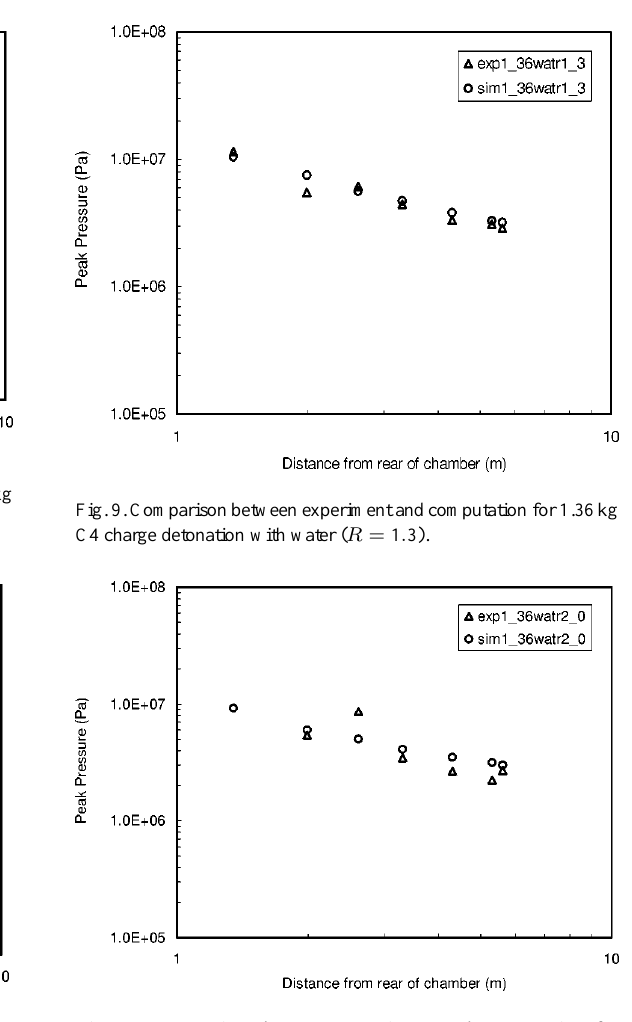
Fig. 8. Comparison between experiment and computation for 1.36 kg C4 charge detonation with water ( R = 2 : 6).